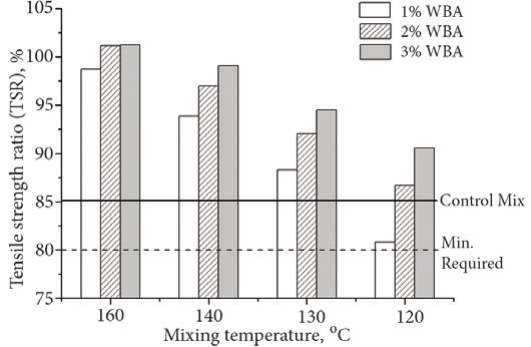
Figure 12. Dry ITS of WMA mixes Figure 13. Tensile Strength Ratio of WMA